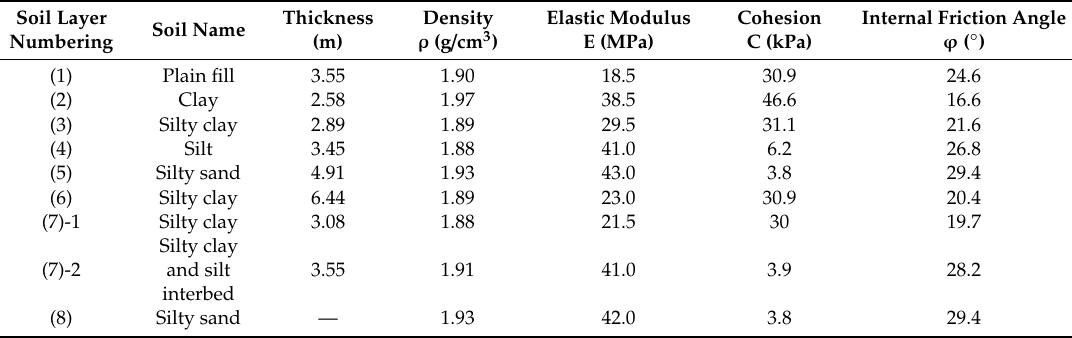
Table 1. Physical and mechanical properties of